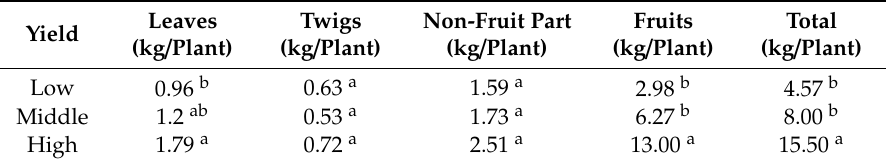
Table 1. The biomass in new organs of citrus trees with respect to yield level. The di ff erent letters (a,b) in the table represent significant di ff erences ( p < 0.05) among yield-levels.